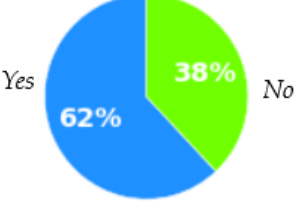
Figure 15. Answers for question of do you think that in China it is essential to set legal exchange platforms of cryptocurrencies and enhance platforms’ management?